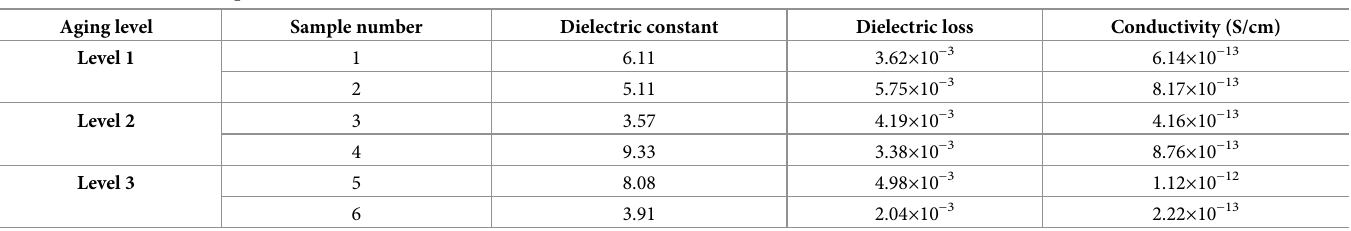
Table 4. Two method correspondence